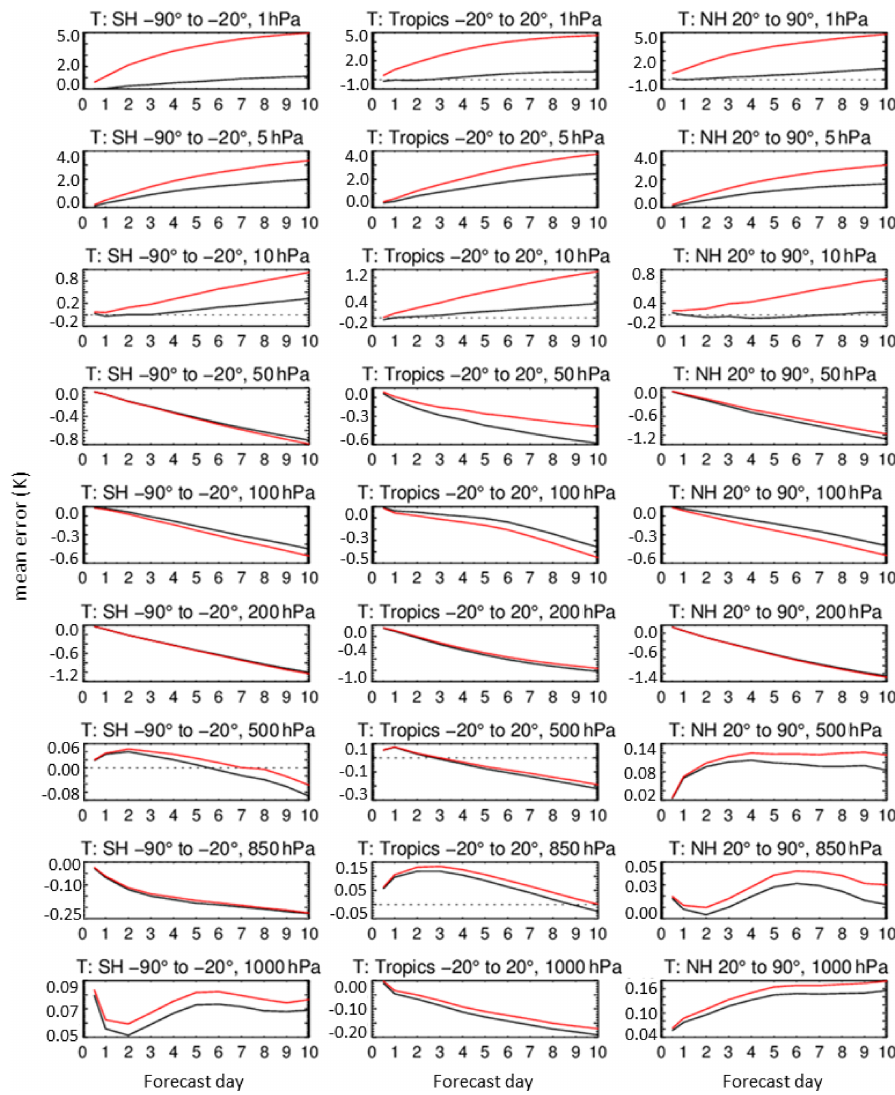
Figure 10. Mean error in the temperature field (K) compared to the operational ECMWF analyses, as a function of lead time for the forecast experiment using the new BMS prognostic ozone (black) and the experiment using the ozone climatology (red) in the radiation scheme. The two 10d forecast model runs cover a 1-year period, from August 2012 to July 2013. The figure shows three latitudinal bands, 90–20 ◦ S (left column), 20 ◦ S–20 ◦ N (centre column) and 20–90 ◦ N (right column), for different pressure levels as labelled for each row, from 1.0 to